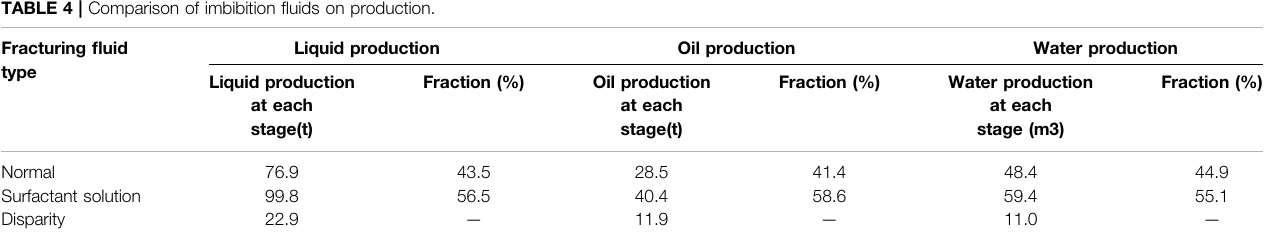
TABLE 4 | Comparison of imbibition fl uids on